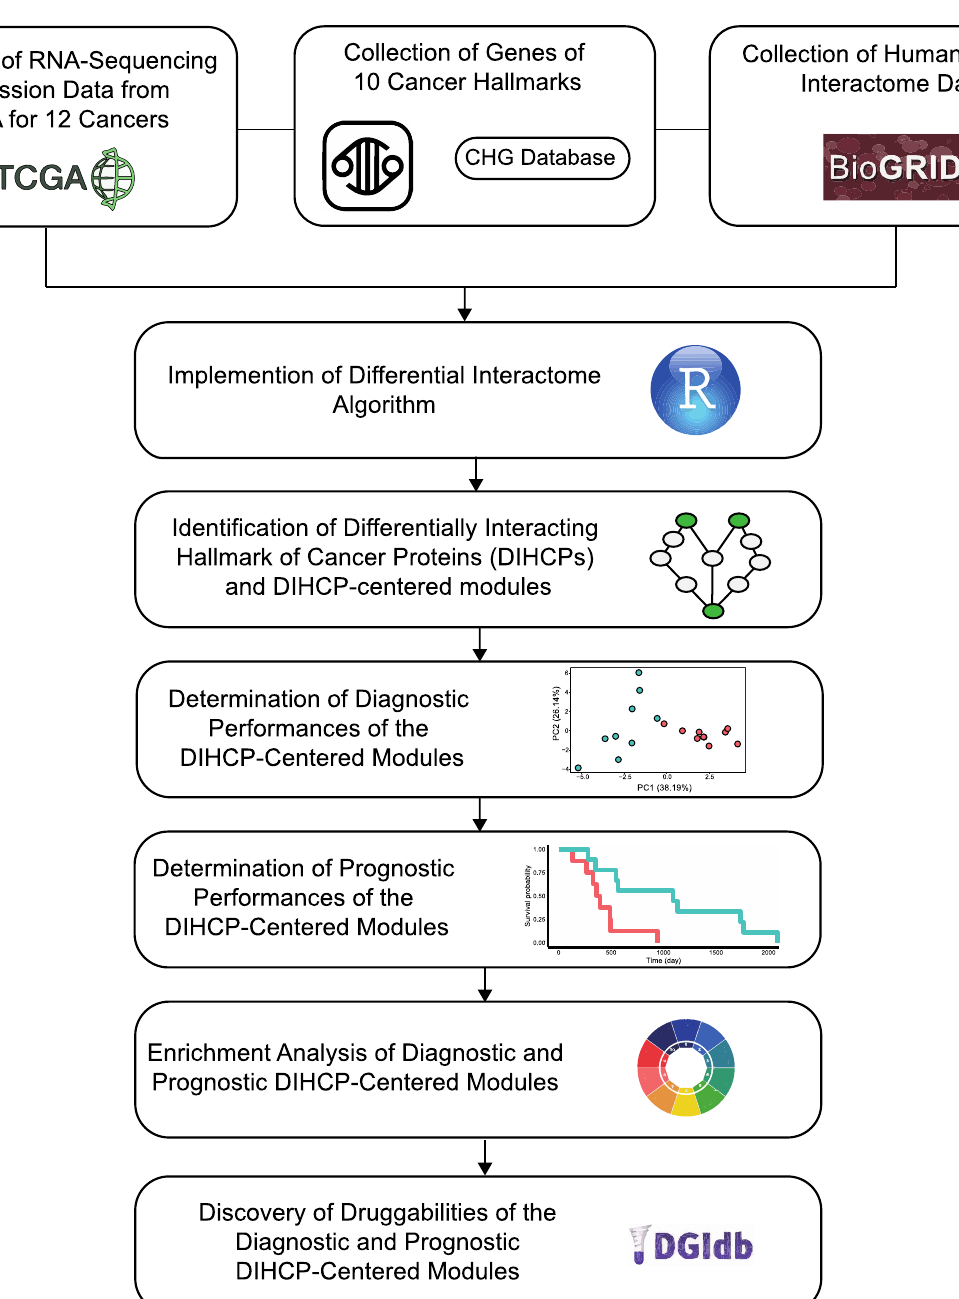
Figure 1. The systematic approach for the study. The steps of the applied systems’ biology methodology for the study. After collecting the data from different repositories, the differential interactome algorithm was applied. This algorithm was used to identify differentially interacting hallmark of cancer proteins (DIHCPs) and DIHCPs-centered modules. The prognostic and diagnostic performance of the DIHCPs-centered modules was evaluated. The enrichment analyses were performed and finally the components of the modules’ druggability were discovered.